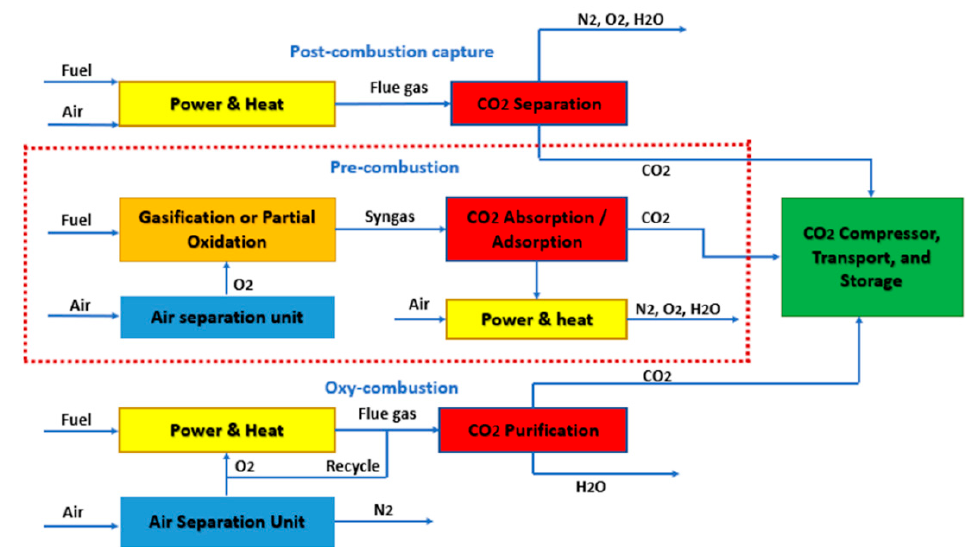
Figure 7. Schematics of CO 2 capture technologies for power plants [22].